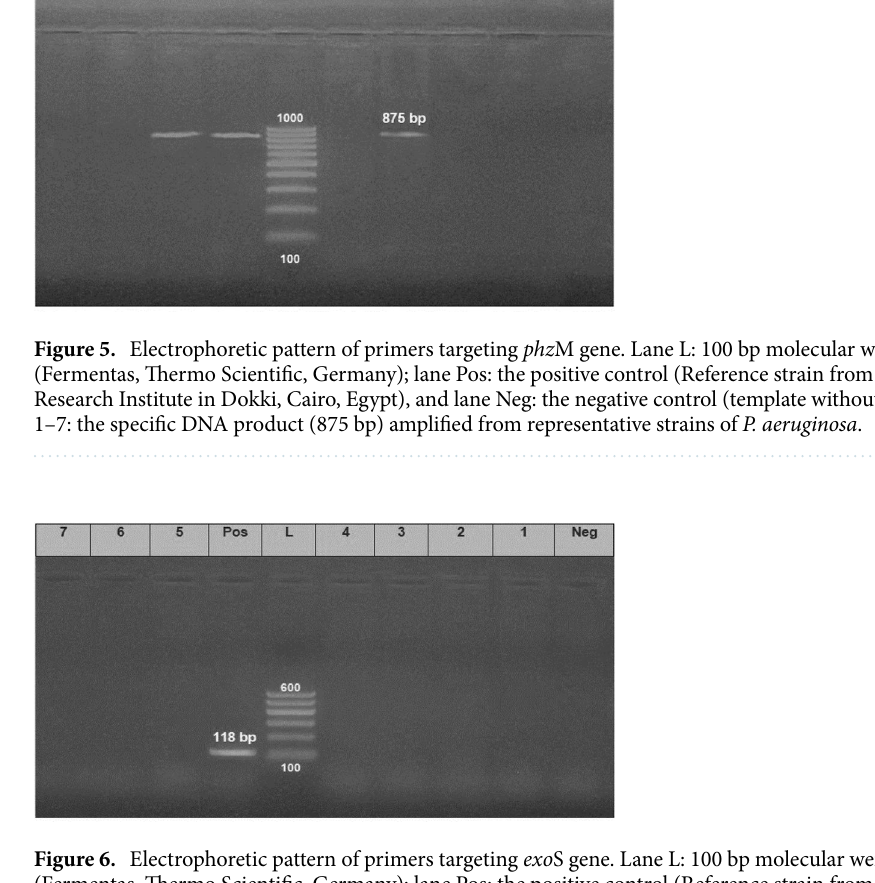
Figure 6. Electrophoretic pattern of primers targeting exo S gene. Lane L: 100 bp molecular weight ladder (Fermentas, Thermo Scientific, Germany); lane Pos: the positive control (Reference strain from Animal Health Research Institute in Dokki, Cairo, Egypt), and lane Neg: the negative control (template without DNA). Lanes 1–7: the specific DNA product (118 bp) amplified from representative strains of P. aeruginosa